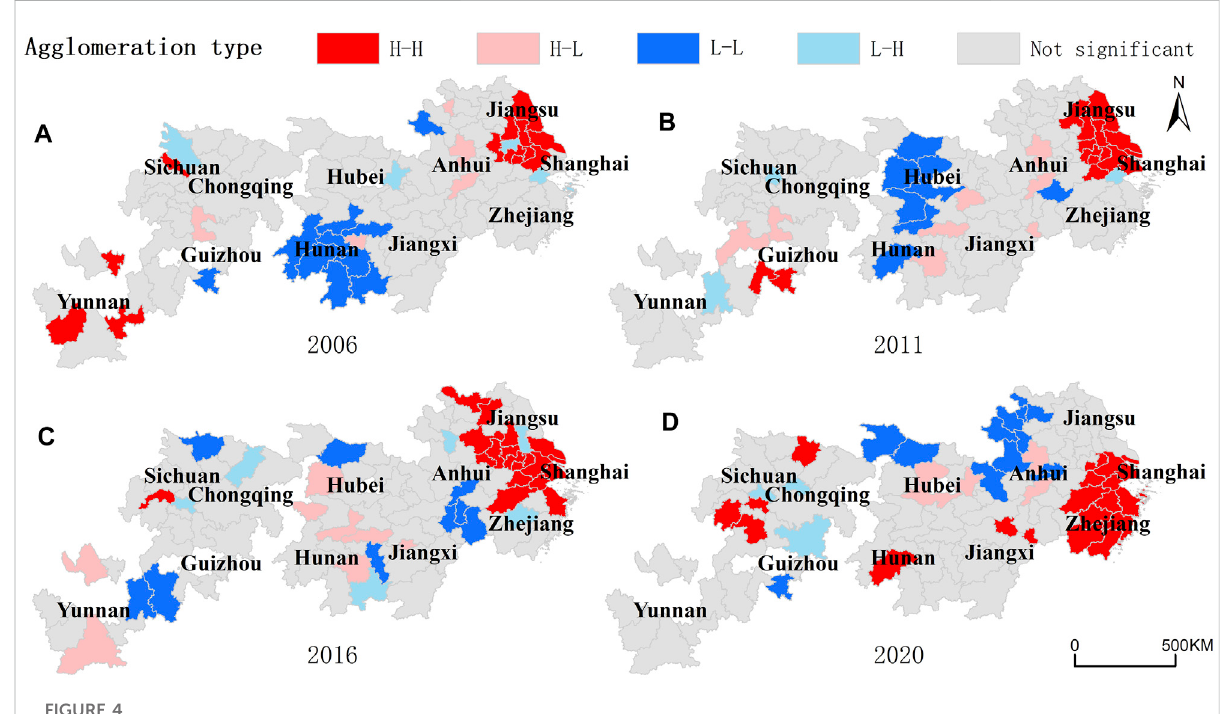
FIGURE 4 LISA cluster diagrams of the eco-ef fi ciency of RED in the study